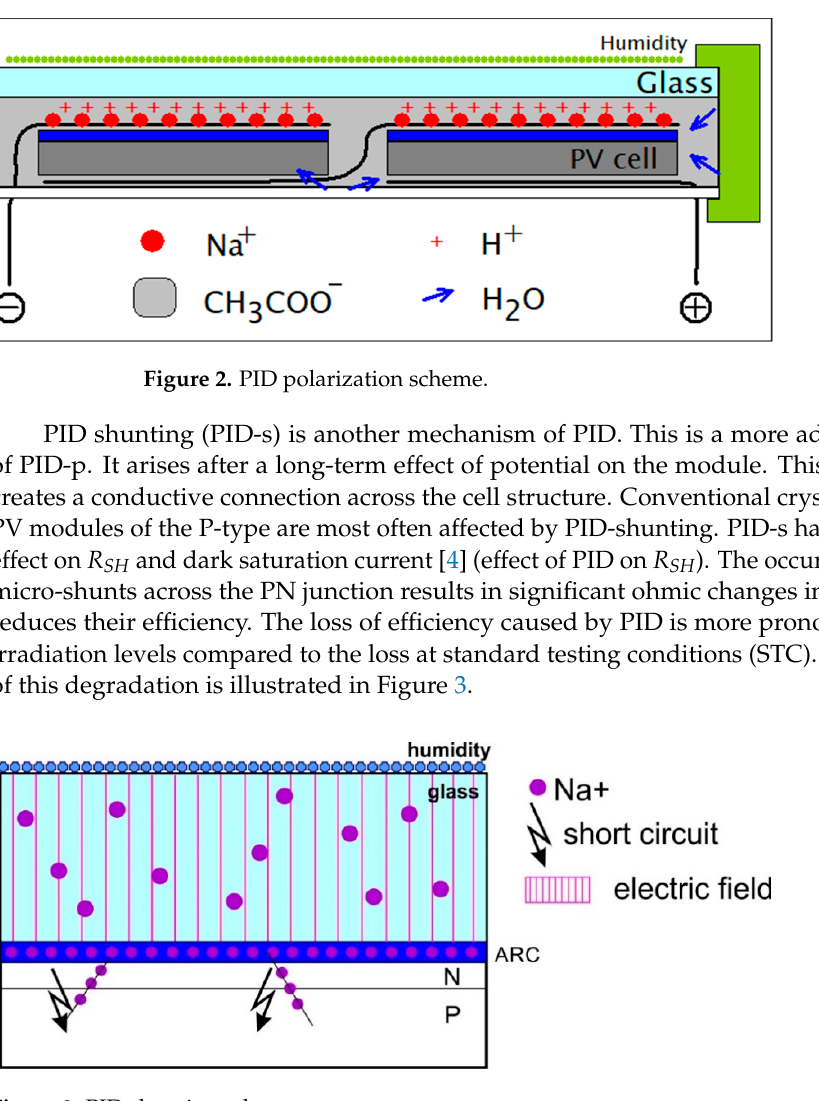
Figure 3. PID shunting scheme.